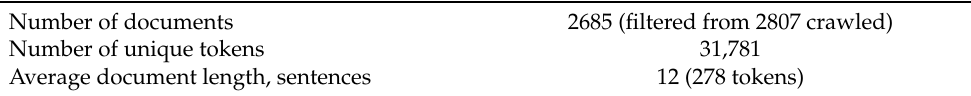
Table 3. The tourism online review collection used to build classifier models. Number of